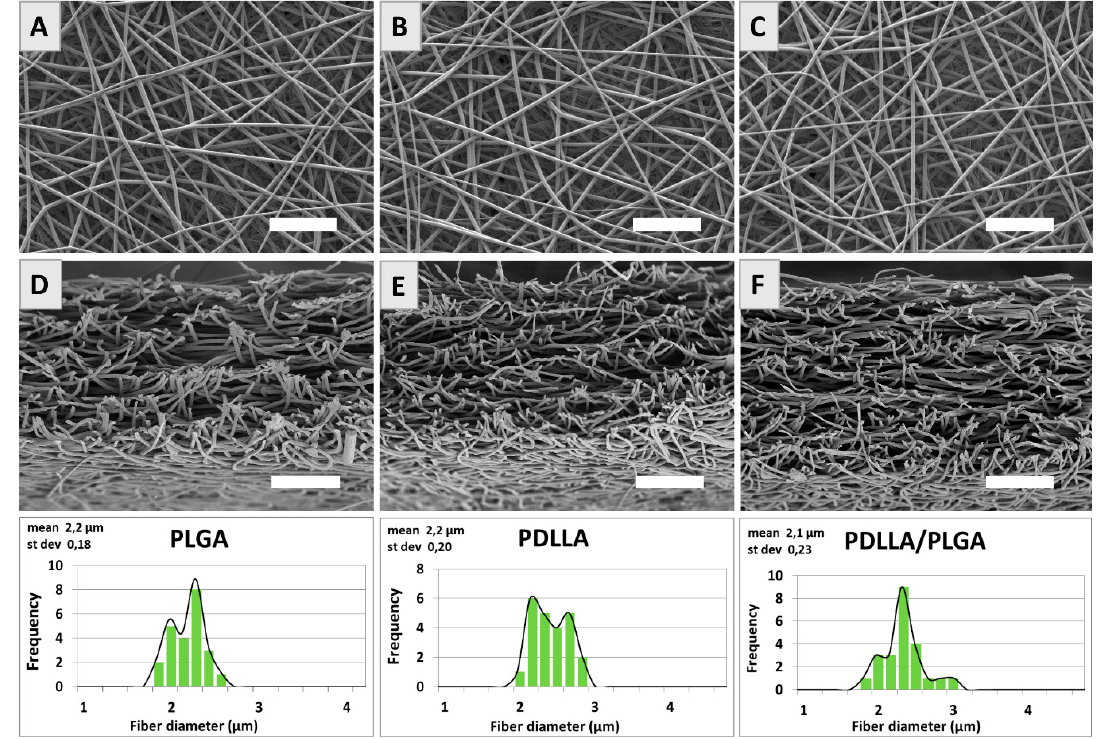
Figure 3. SEM images of PLGA, PDLLA and PDLLA/PLGA samples top view ( A – C ) and fractured in liquid nitrogen cross-sections ( D – F ). For each material, fiber diameter histograms are given. Scale bar is 50 µm.